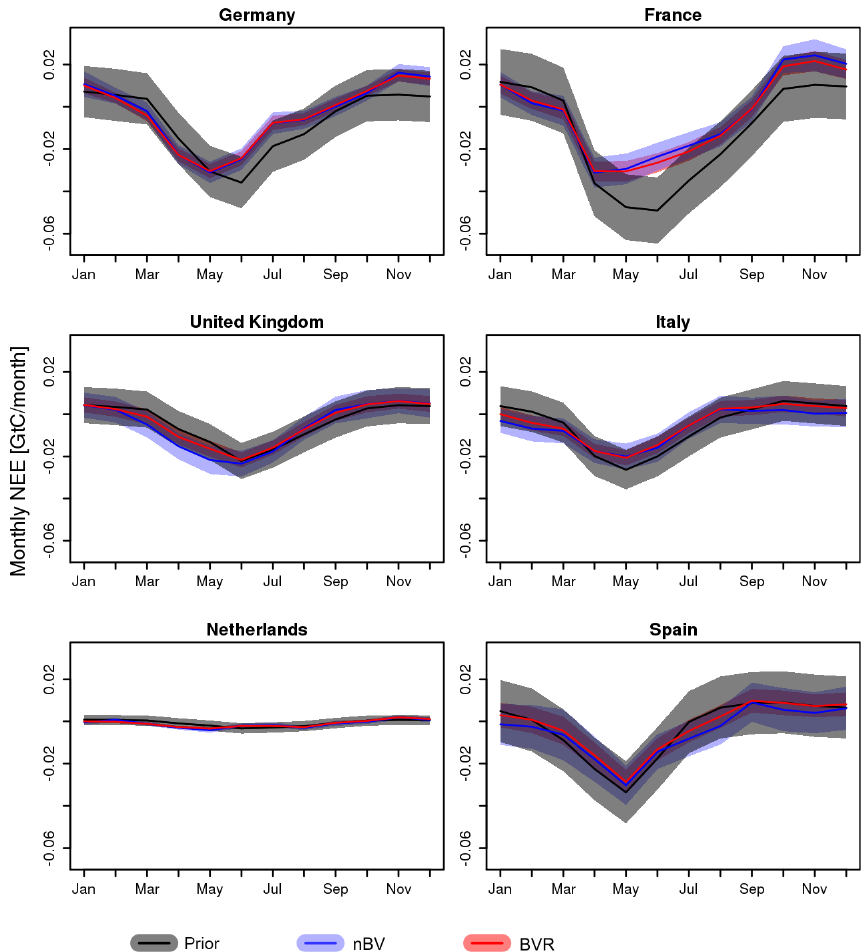
Figure 6. Temporal evolution of prior and posterior monthly NEE for selected European